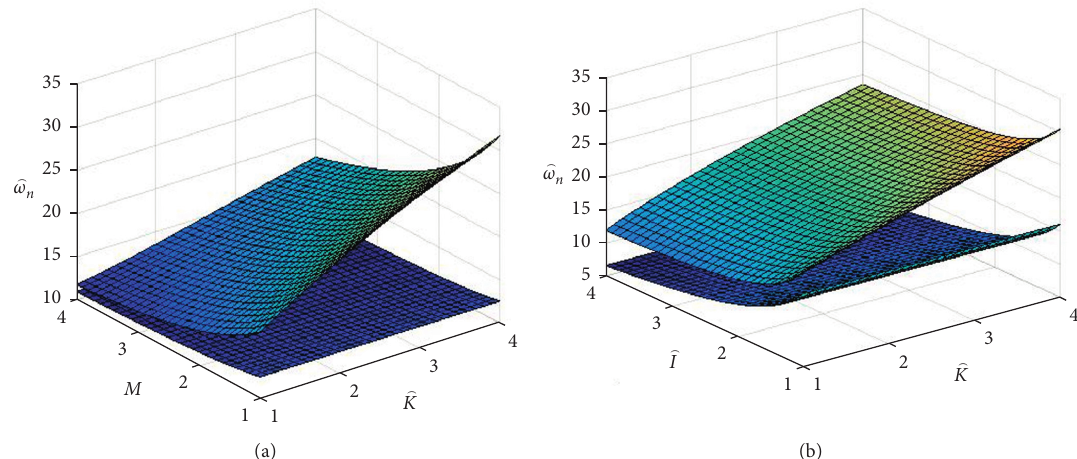
Figure 13: The effect of changing (a) K ⌢ and M and (b) K ⌢ and I ⌢ on the starting and ending frequencies of the bandgap for 1DOF model.